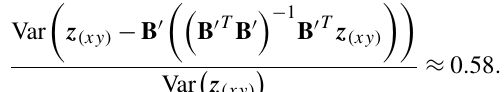
Figure 1. Flow diagram of the proposed calibration procedure. Hor- izontal boxes represent steps in the analysis, diamonds represent observations and numbers refer to corresponding sections in this